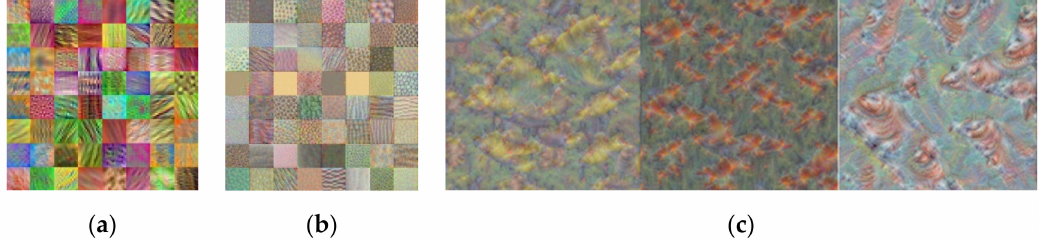
Figure 10. Features learned in GoogLeNet: ( a ) the first 64 features extracted in the 2nd convolution layer; ( b ) the first 64 feature output in the 1st inception module; ( c ) the first three outputs in the last fully connected layer.